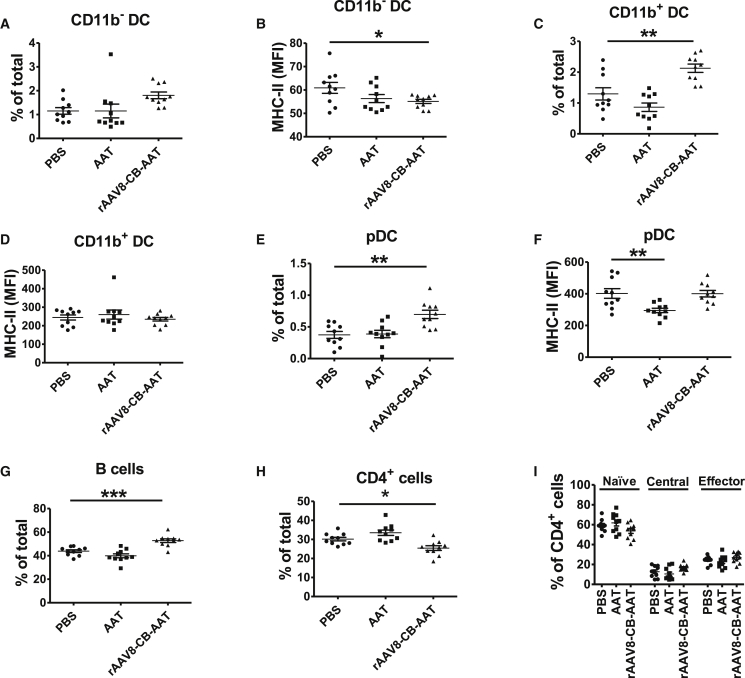
Effect of hAAT Treatment on NZM2410 Splenocytes after 14 Weeks of TreatmentMice described in Figure 4 were sacrificed at 22 weeks. Splenic conventional DCs were identified as CD11c+ with CD11c+CD11b− (presented as CD11b−) and CD11c+CD11b+ (presented as CD11b+) subsets, plasmacytoid DCs (pDC) as PDCA-1+CD11cint, and B cells as CD19+ cells. The frequency of these cells was calculated relative to total live splenocytes. CD4+ T cells were subdivided into naive (CD62L+CD44−), central memory (CD62L+CD44+), and effector memory (CD62L−CD44+). (A) Frequency of CD11b− DCs. (B) Expression of MHC-II on CD11b− DCs (gated on CD11c+CD11b− DCs). PBS versus rAAV-CB-hAAT was analyzed by two-tailed unpaired t test. (C) Frequency of CD11b+ DCs. (D) MHC-II expression on CD11b+ DCs indicated as MFI (gated on CD11c+CD11b+ DCs). (E) Frequency of pDC (PDCA-1+CD11cint, gated on total live cells). (F) MHC-II MFI expression on pDCs (gated on pDCs). (G) Frequency of B cells (CD19+ cells gated on total live cells). (H) Frequency of CD4+ cells (CD4+ cell gated on total live cells). (I) Frequency of naive (CD62L+CD44−), central memory (CD62L+CD44+), and effector memory (CD62L−CD44+) T cells (gated on CD4+ T cells). Data were expressed as the mean ± SEM for ten mice per group and analyzed by one-way ANOVA using Tukey’s post hoc test. *p < 0.05, **p < 0.01, ***p < 0.001.